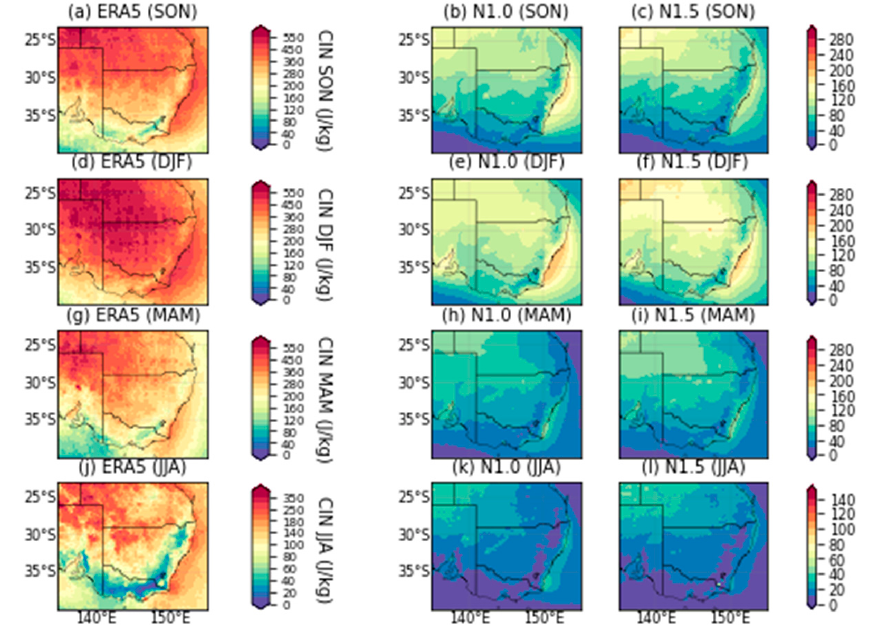
Figure A17. As in Figure A15 except for CIN.